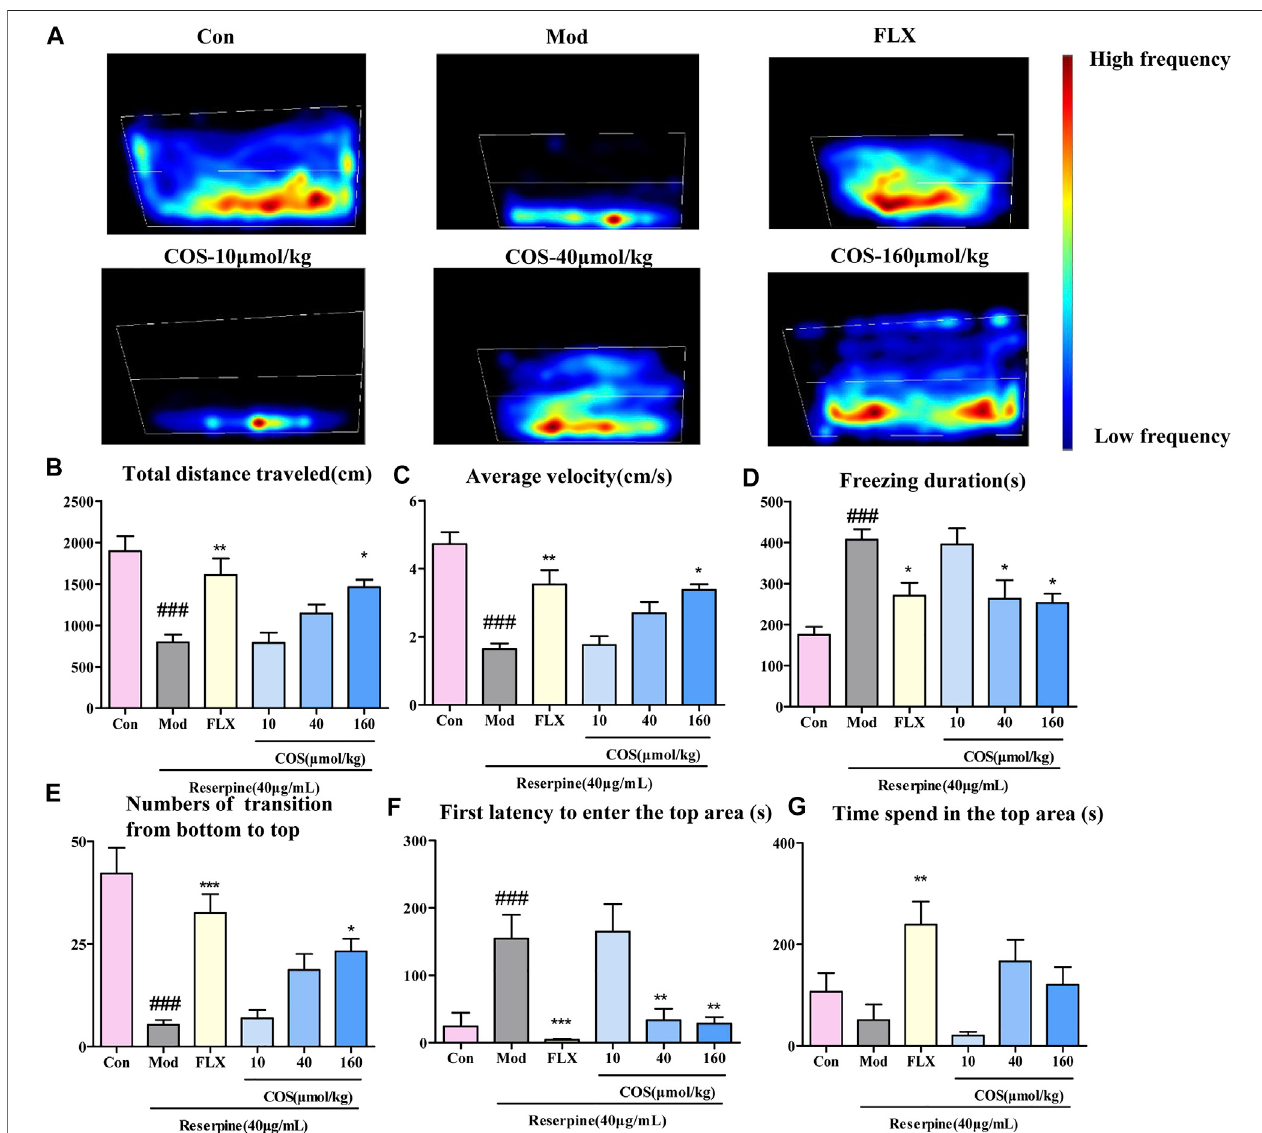
FIGURE4| Antidepressanteffectofcostunolide(COS)wastestedusinganoveltankdivingtest. (A) .Heatmapsofthebehaviortrajectory.Thebarchartshowsthe swimmingability,freezingbehaviorandexploratorybehaviorofadultzebra fi sh. (B) .Totaldistancetravelled(cm) (C) .Averagevelocity(cm/s) (D) .Freezingduration(s) (E) . Numbers of transition from bottom to top (F) . First latency to enter top area (s) (G) . Time spend in the top area Data are expressed as the mean ± SEM (n (cid:1) 10/group). . Signi fi cance was de fi ned as ### p < 0.001 * p < 0.05, ** p < 0.01, *** p < 0.001.